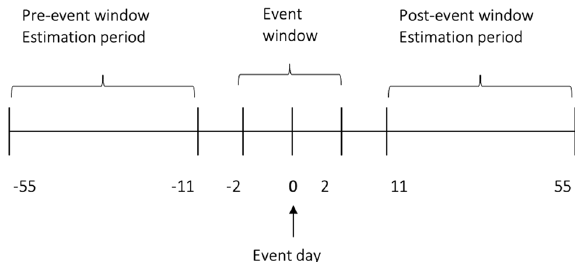
Fig. 9 Volume pre‑event and event window. Source : Created by